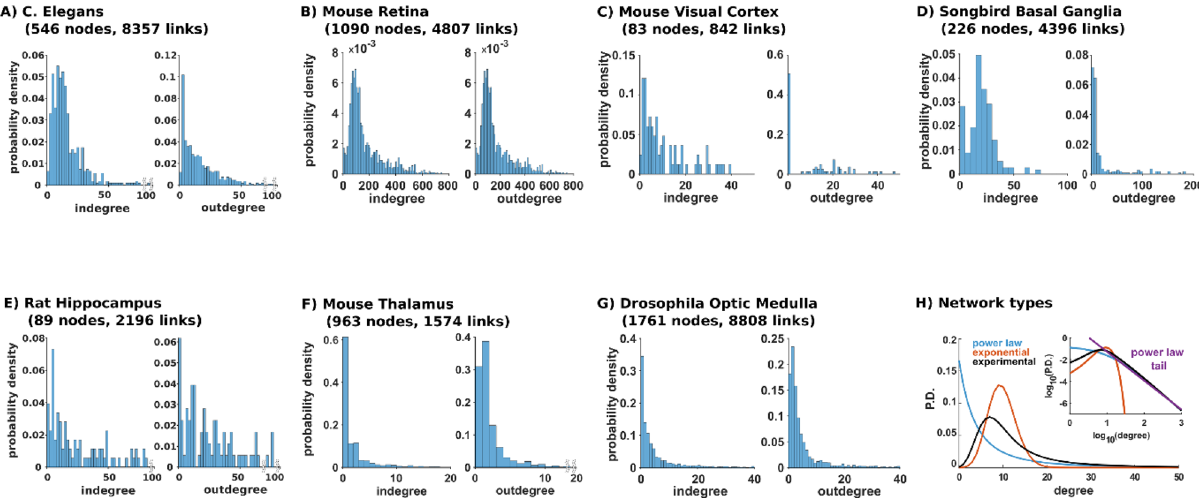
Figure 1. Degree distributions of different brain networks. ( A ) The 546 neurons of the C. elegans adult male nervous system 5 ; ( B ) from a dense reconstruction of 1090 neurons from a mouse retina inner plexiform layer 9 ; ( C ) from electron microscopy data on a 3 million μm 3 volume of L2/3 mouse primary visual corte 10 ; ( D) from electron microscopy data on 226 neurons from a Songbird basal ganglia 11 ; ( E ) 89 neurons from a slice from a rodent hippocampus 8 (courtesy of Paolo Bonifazi); ( F ) mouse thalamus (Morgan et al. 7 ); ( G ) from electron microscopy data containing 1761 body ID’s from a Drosophila Optic Medulla 12 ; ( H ) Schematic representation of degree distribution for different model networks: Power Law (blue), exponential (red) and stereotypical experimentally observed distribution (black). The inset shows a log–log plot with a (purple) line representing the Power Law tail; note how the power law tail line fails to reproduce the low degree